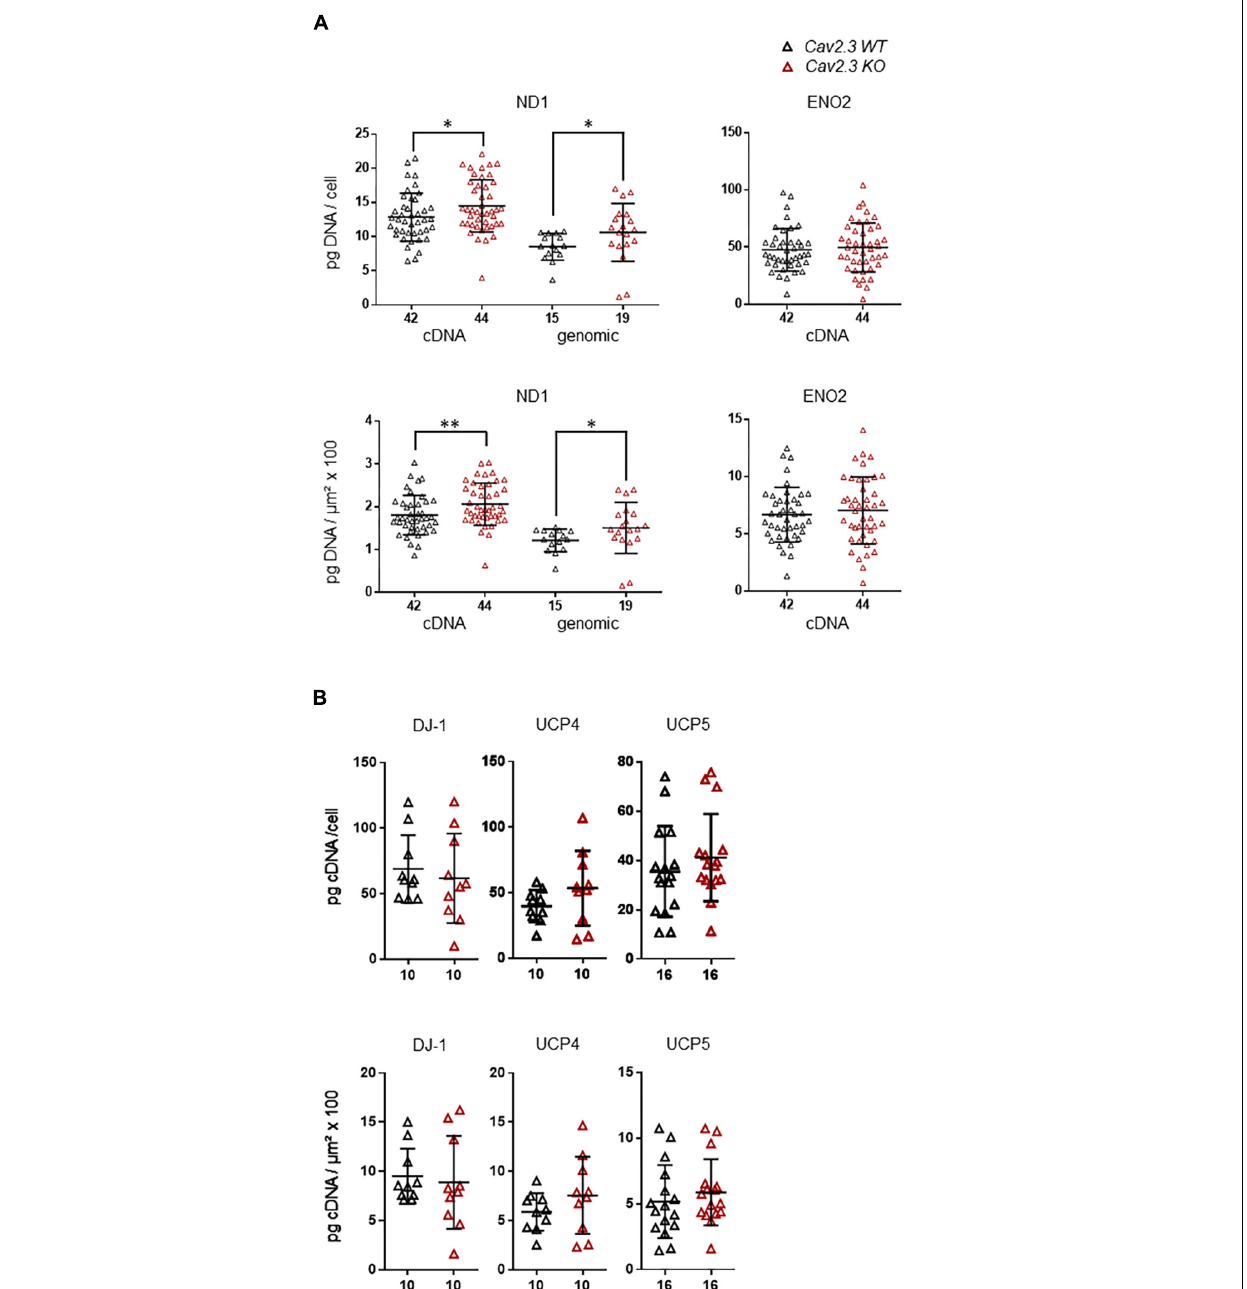
FIGURE 4 | Higher expression levels selectively of ND1 cDNA and genomic DNA in SN DA neurons from Cav2.3 KO mice compared to WT. (A) Left: qPCR-derived relative cDNA and genomic DNA levels of mitochondrially coded NADH-ubiquinone oxidoreductase chain 1 (ND1) in individual TH positive SN DA neurons from adult Cav2.3 WT and KO mice, relative to respective tissue cDNA derived standard curves (in pg/cell, upper), or normalized to specific laser-microdissected neuron sizes (in µ m 2 × 100, lower). Note that ND1 cDNA levels reflect cDNA + genomic DNA-derived signals, as the ND1 gene contains no intron, and cDNA as well as genomic ND1 levels are elevated in the KO. Right: Similar qPCR-derived relative cDNA levels for the same samples as in ( A , left) for the neuron-specific enolase (ENO2). (B) Relative RT-qPCR-derived data from individual TH positive SN neurons from Cav2.3 KO and WT mice for the genes as indicated (displaying lower mRNA levels in SN DA neurons from NCS-1 KO mice). All data are given as scatter plots with mean ± SD. Significant differences are indicated according to Mann–Whitney U-tests and marked with asterisks ( ∗ p ≤ 0.05; ∗∗ p < 0.01). Numbers of analyzed individual SN DA neuron-derived cDNA samples (n) are given on the x-axis. All data and statistics detailed in Supplementary Figure S2 and Supplementary Tables S2, S4